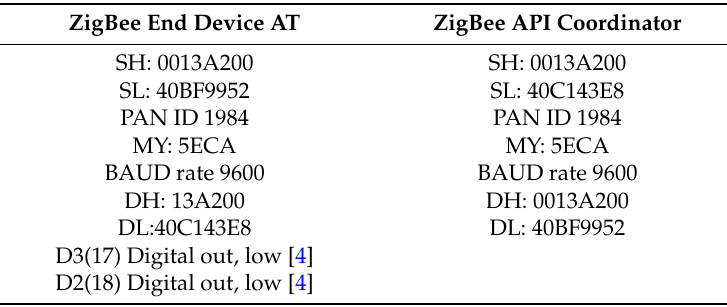
Table 1. XBee modules configuration.